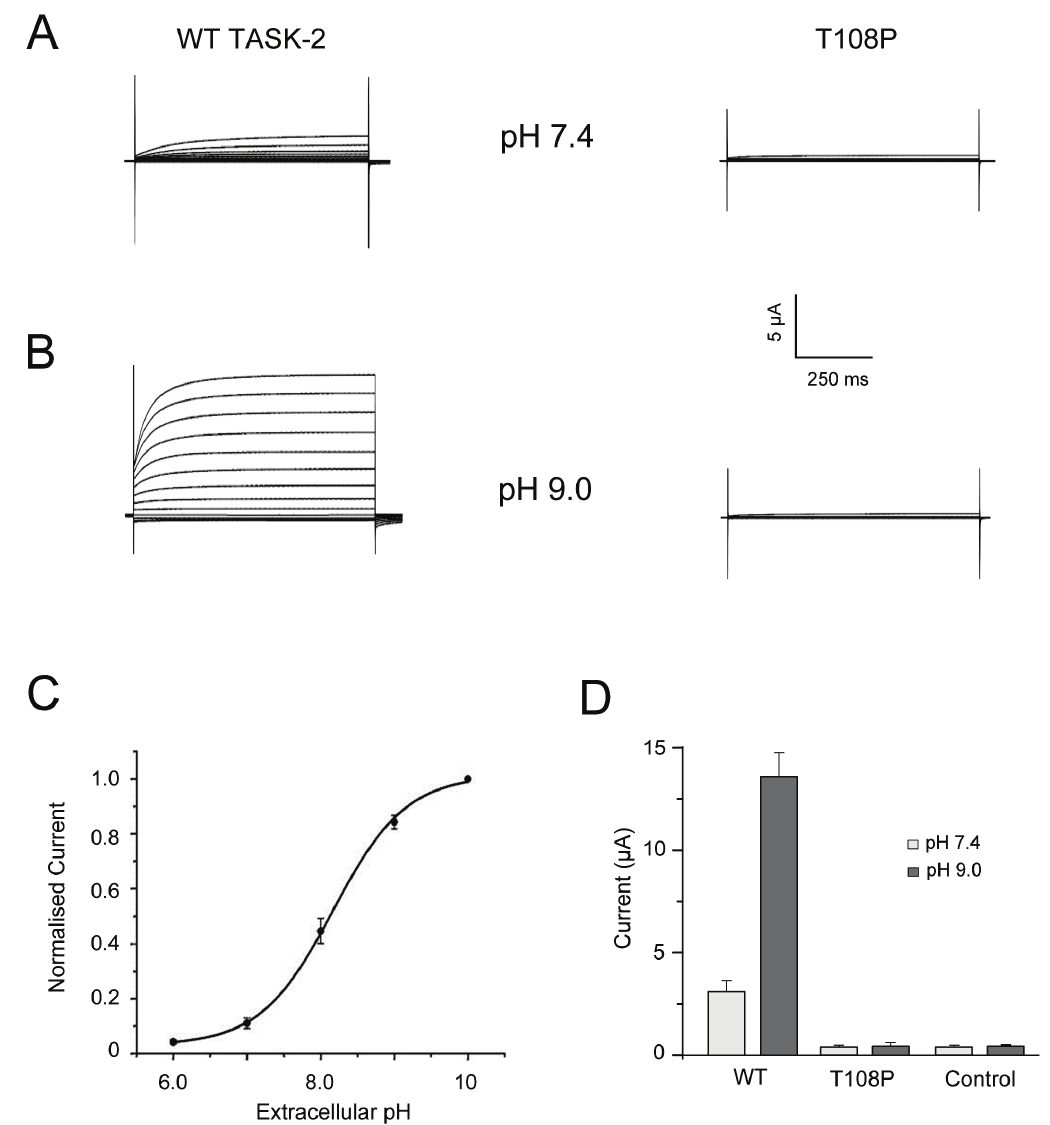
Fig 1. T108P variant in TASK-2 causes a loss of function. (A) Representative whole-cell current traces at physiological extracellular pH 7.4 recorded from oocytes injected with equivalent amounts of mRNA for either WT TASK-2 or the T108P variant. Currents were recorded using 300 ms voltage steps from a holding potential of -80 mV delivered in 20 mV increments between -140 mV and +100 mV. (B) Similar currents recorded after extracellular. (C) Activation of WT TASK-2 currents at alkaline pH. Results shown as means ± s.e.m. (D) Averaged whole-cell currents from uninjected control oocytes and cells expressing either WT or T108P TASK-2 channels at the indicated external pH values (WT vs T108P, P < 0.01 at pH 7.4 and pH 9, one-way ANOVA, post-hoc Tukey HSD test; n = 9 for all